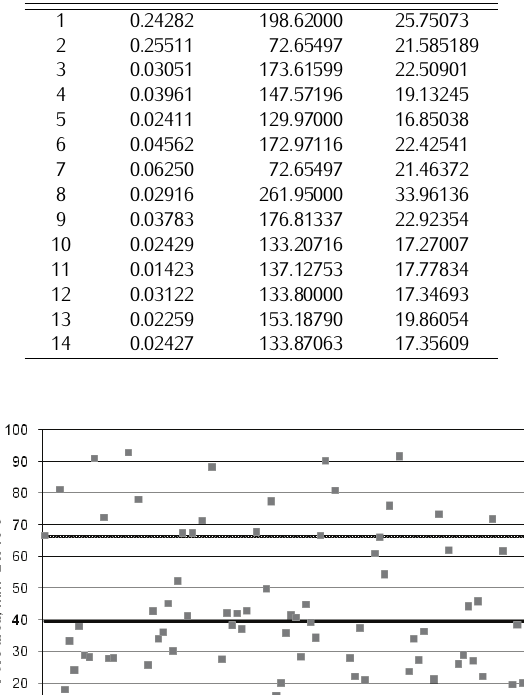
The results of the measured mean area are compared with theoretically calculated pore area, on the basis of the equation 1. The comparison of the values is presented on Fig.